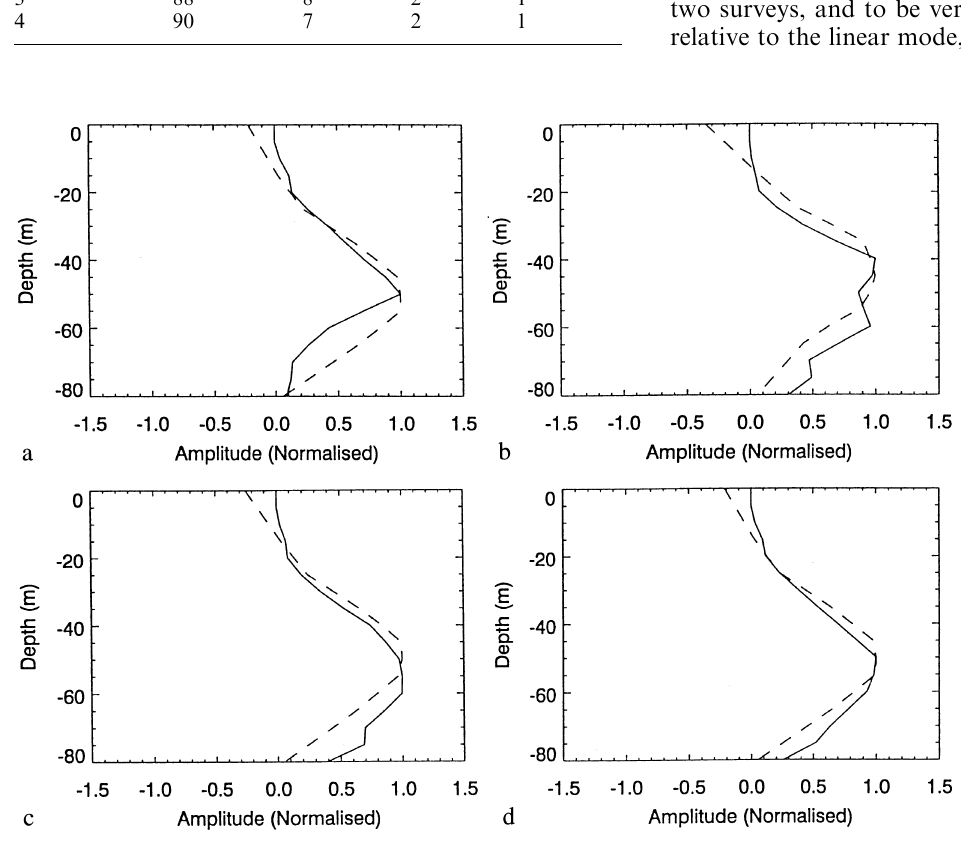
Fig. 12a–d. The first linear mode of temperature fluctuation ( solid line ) and first EOF ( dashed line ) for each of the four surveys, a–d . Both EOF and linear mode are normalised to a maximum of 1